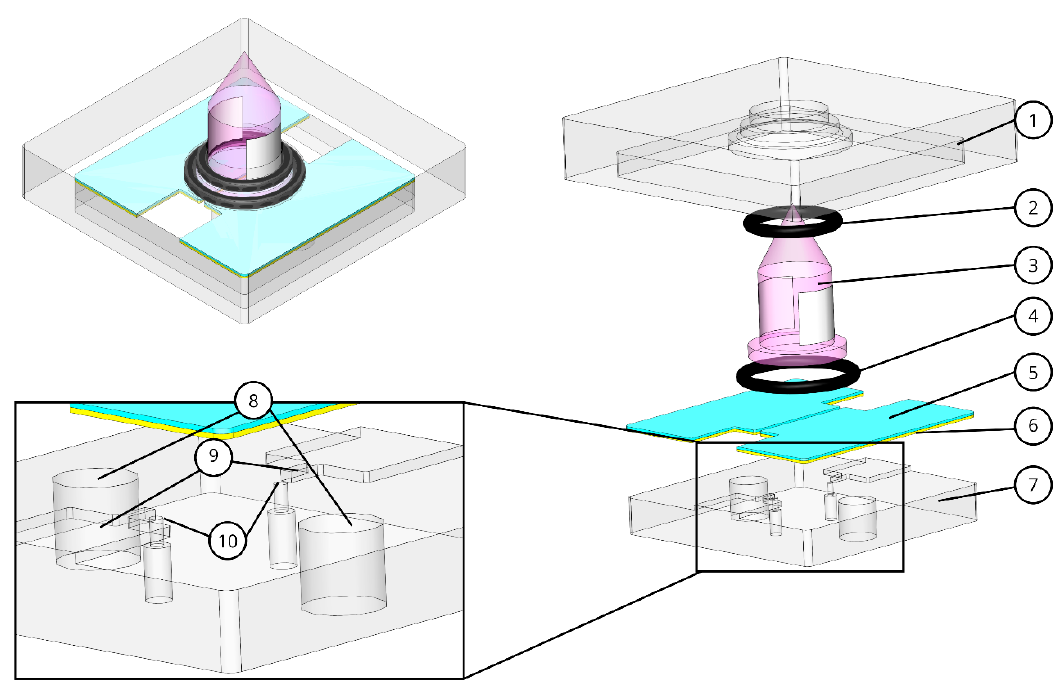
Figure 1. Assembled and exploded view of the detector core. ( 1 ) Top poly(methyl methacrylate) (PMMA), ( 2 ) O-ring 1, ( 3 ) UV lamp, ( 4 ) O-ring 2, ( 5 ) shield, ( 6 ) copper electrodes, ( 7 ) bottom PMMA, ( 8 ) electrode connection holes, ( 9 ) elevation structure, ( 10 ) micro-pores.